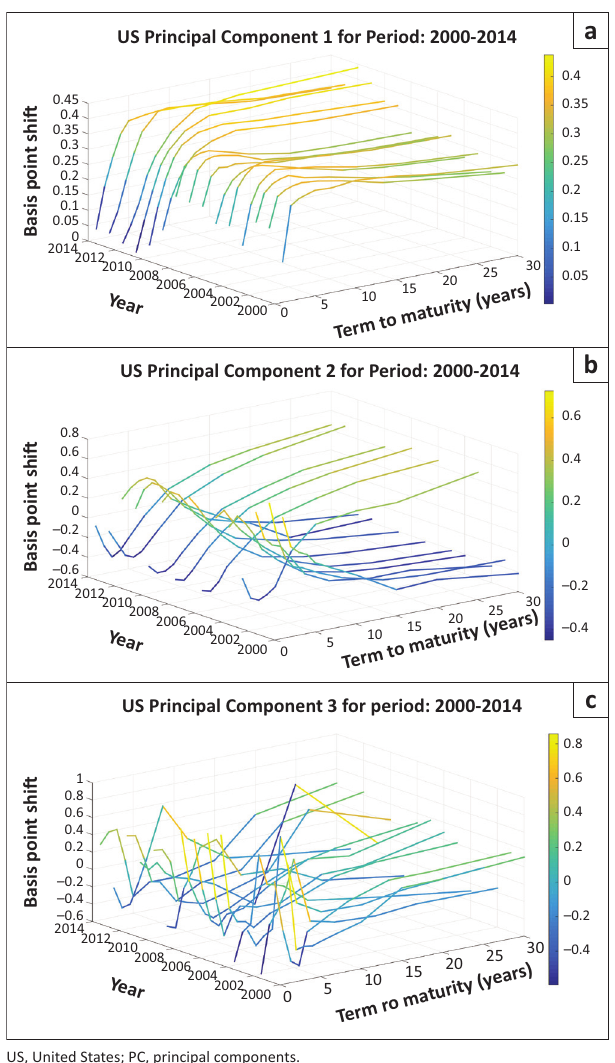
FIGURE 9: Three-dimensional representation of annual US principal components for the period 2000–2014: (a) US annual PC1; (b) US annual PC2; and (c)